Question: What type of chart is this?
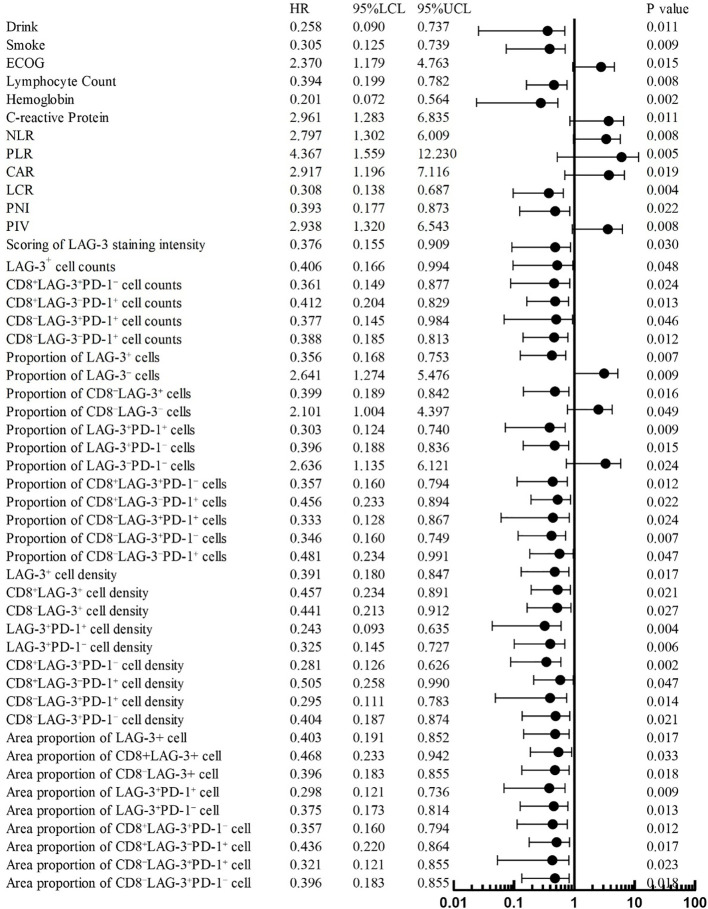
Answer: forest